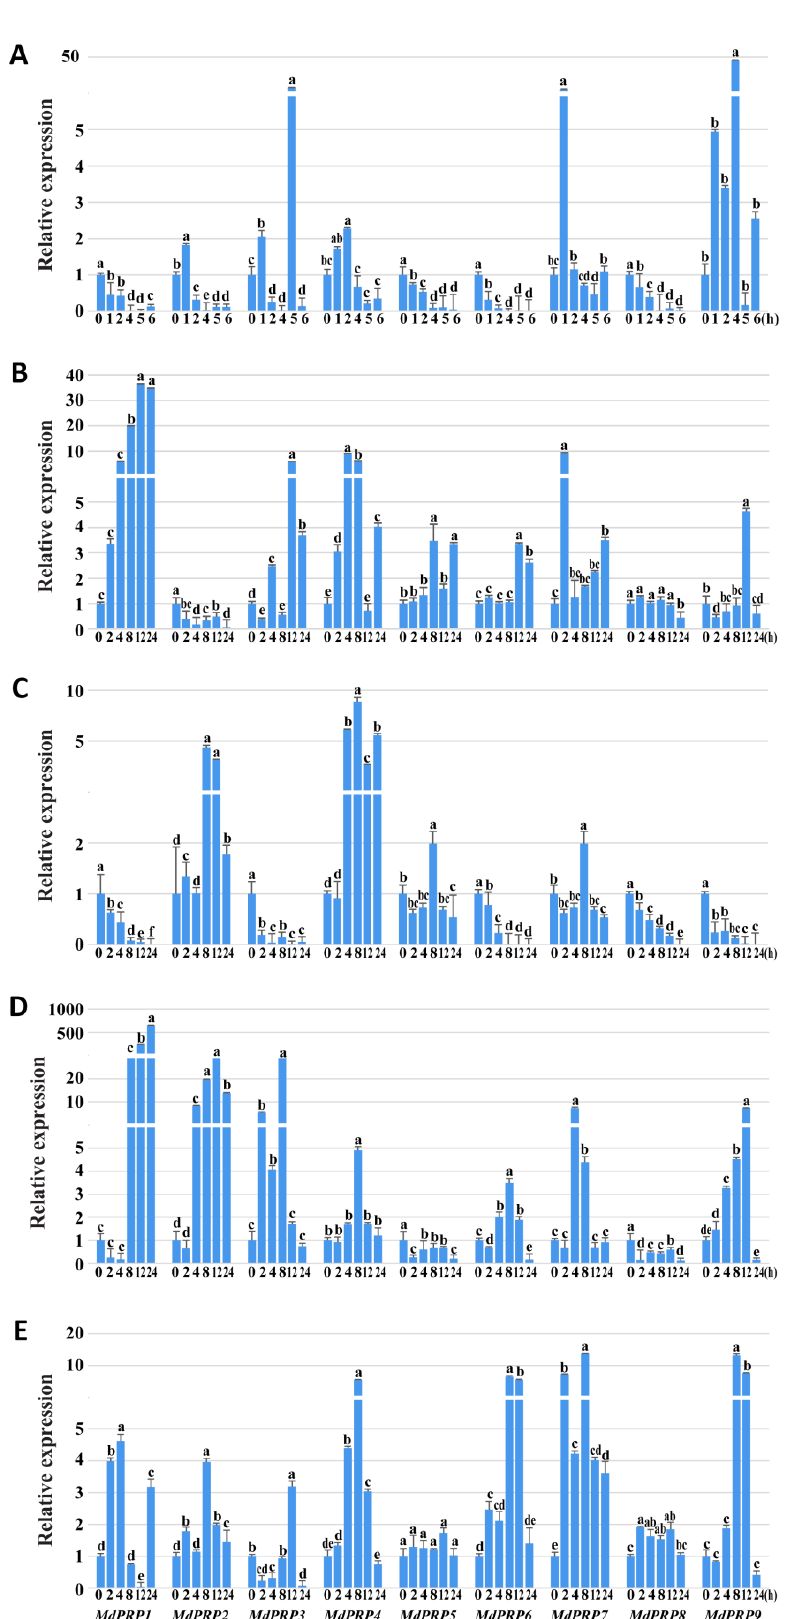
Figure 5. Relative expressions of MdPRPs in response to various stresses. ( A ) Heat treatment: treatment at 48 °C for 6 h, and the heat stress-treated leaves were collected at 0, 1, 2, 4, 5, 6 h; ( B ) cold stress: treatment at 4 °C for 24 h, and the cold-treated leaves were collected at 0, 2, 4, 8, 12, 24 h; for (C ) drought stress, ( D ) salt stress, and ( E ) ABA stress, PEG6000 (10%;